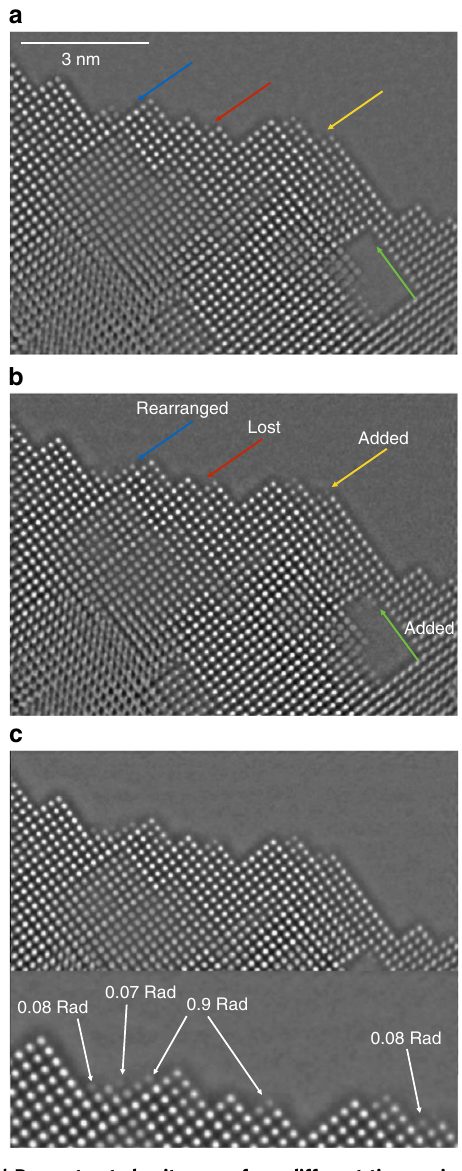
Figure 6 | Reconstructed exit waves from different time series. ( a ) Reconstructed exit wave from the first 35 time series images. ( b ) Recon- structed exit waves from the 35th to the 70th images. The edge atoms are obviously altered via electron beam–sample interaction. ( c ) Reconstructed exit waves using the images of whole time series. The phase value from the edge atoms can be read to be B 0.08rad. Scale bar, 3nm in all